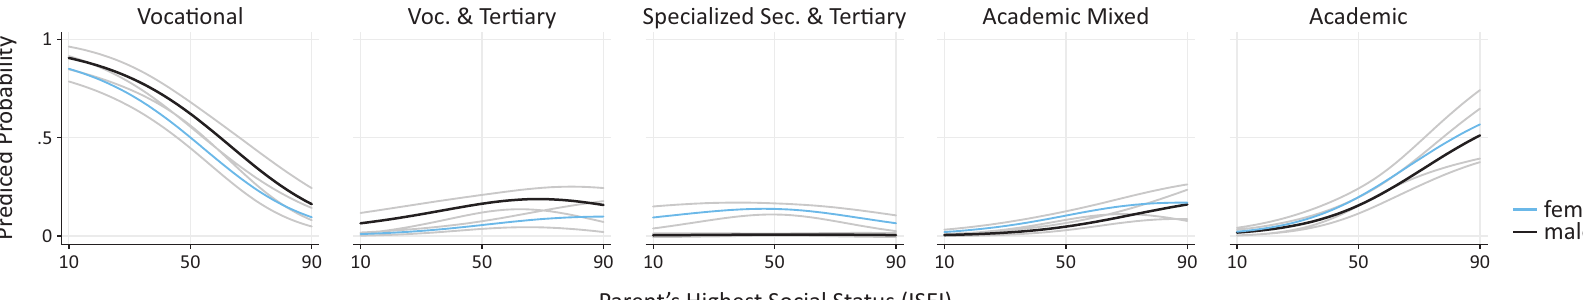
Figure 4. Probabilities of belonging to a certain cluster, by social origin and gender, total effect, grey lines: 95%-CI.